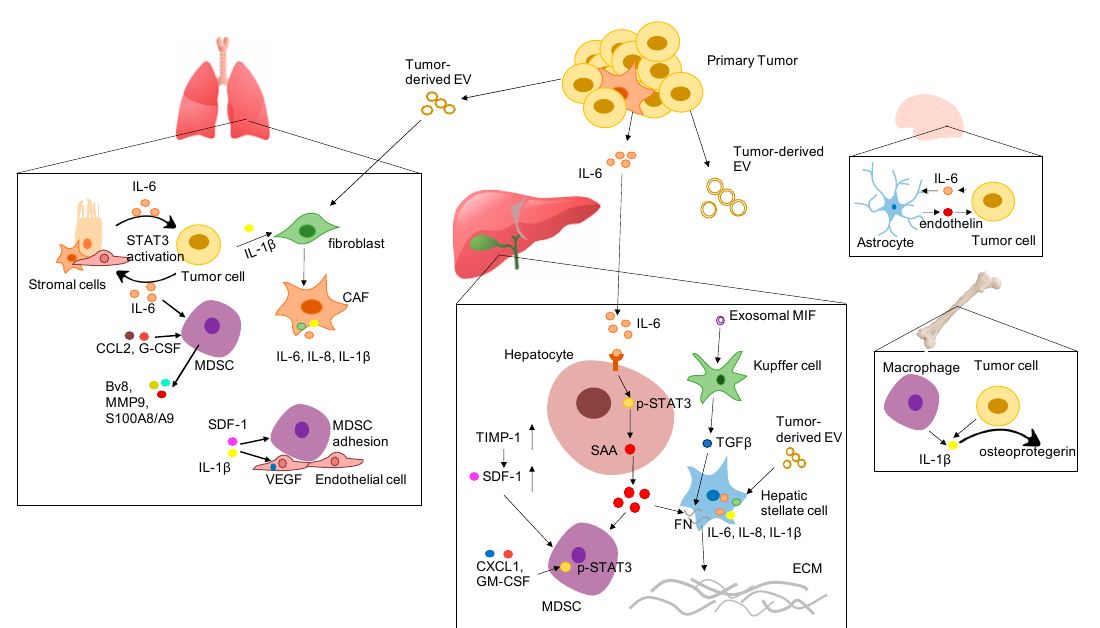
Figure 1. Proposed mechanisms by which various pro-inflammatory cytokines promote the formation of the pre-metastatic niche in different organs. Abbreviation: EV: extracellular vesicles; IL-6: interleukin 6; IL-1 β : interleukin-1 β ; SDF-1 α : stromal cell-derived factor 1; IL-8: interleukin 8; VEGF: vascular endothelial growth factor; G-CSF: granulocyte-colony stimulating factor; CCL2: CC-chemokine ligand 2; CXCL1: C-X-C motif ligan 1; MIF: macrophage migration inhibitory factor; TIMP-1: tissue inhibitor of metalloproteinases 1; GM-CSF: granulocyte-macrophage colony-stimulating factor; SAA: serum amyloid A; TGF- β : transforming growth factor beta; FN: fibronectin; ECM: extracellular matrix; STAT3: signal transducer and activator of transcription 3; CAF: cancer associated fibroblast; MDSC: myeloid-derived suppressor cells.